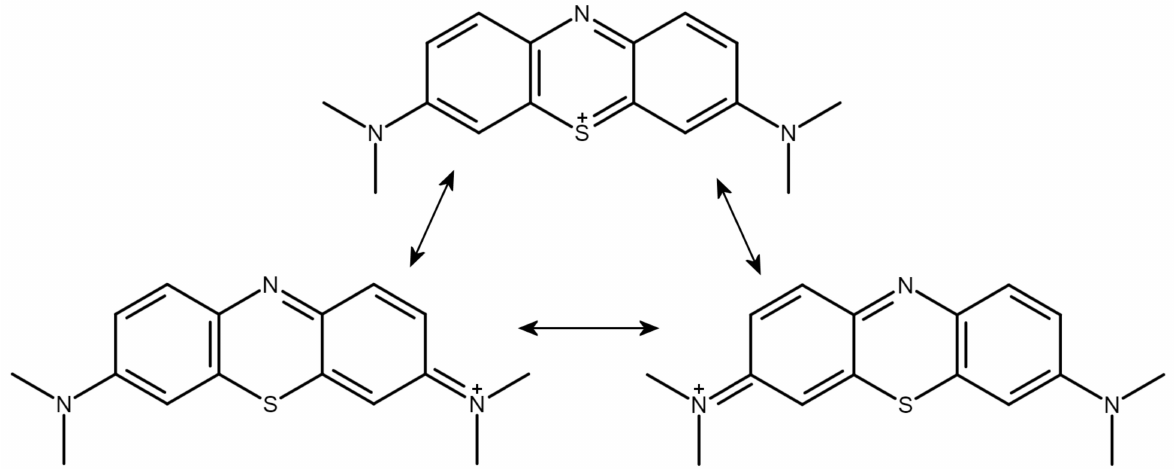
Figure 1. Conventional valence bond structures of the methylene blue cation with suggestions for the sites of the positive charge. Note that the most positive charges are located on the terminal methyl groups (see